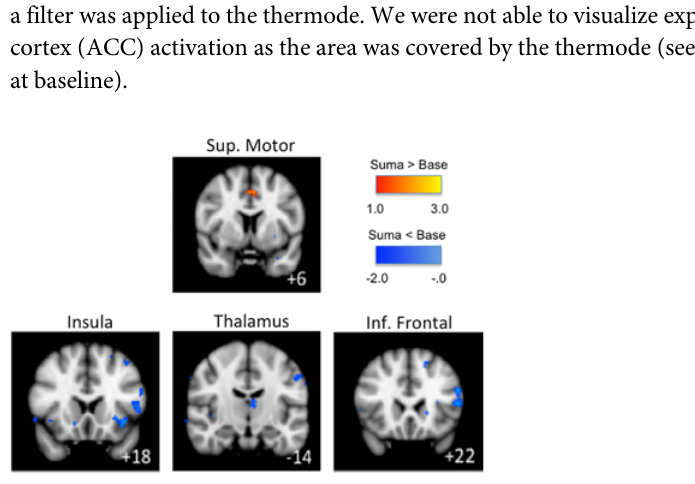
Fig 9. BOLD-signal after sumatriptan administration: Group BOLD-fMRI results for noxious stimulation to the V1 area on the placebo day. Here differences in neuronal activation between the BOLD- fMRI scan at T -5 (baseline) and T 60 (after sumatriptan) is shown. Sumatriptan injection resulted in positive activation of the supplementary motor area (sup. motor area) and negative activation in the inferior frontal cortex (inf. frontal), insula and